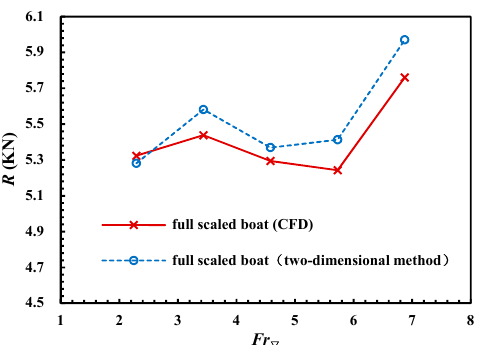
Figure 17. Resistance of the real hull from two-dimensional method and numerical simulation.